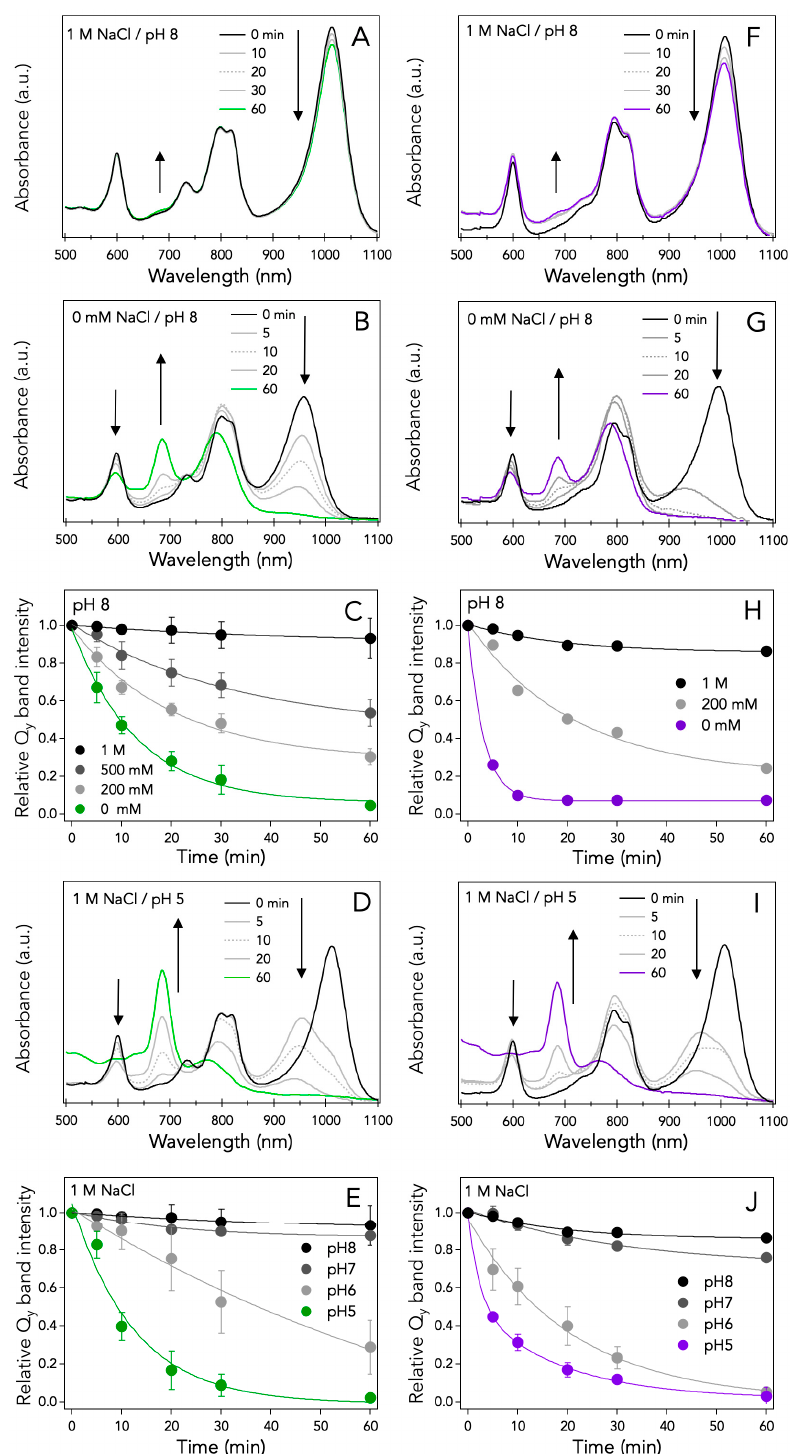
Figure 2. Absorption spectra of the LH1-RCs from Hlr. halochloris ( A , B ) and Hlr. abdelmalekii ( F , G ) at pH 8 in the presence of 1 M NaCl ( A , F ) or in the absence of NaCl ( B , G ) after incubation at 45 °C for indicated time. The time profiles of the relative Q y band intensities for the Hlr. halochloris ( C ) and Hlr. abdelmalekii ( H ) LH1-RCs, respectively, incubated at 45 °C and pH 8 in the presence of indicated concentration of NaCl. Absorption spectra of the LH1-RCs from Hlr. halochloris ( D ) and Hlr. abdelmalekii ( I ) at pH 5 in the presence of 1 M NaCl. The relative Q y band intensities of the Hlr. halochloris ( E ) and Hlr. abdelmalekii ( J ) LH1-RCs after incubation at 45 °C for 60 min at indicated pH in the presence of 1 M NaCl.